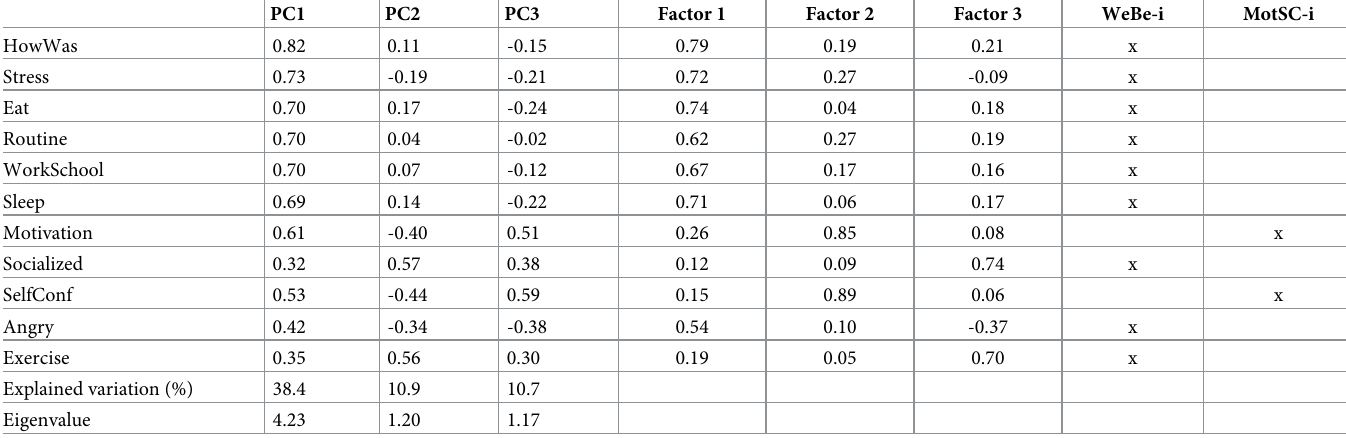
Table 4. Principal components (PC1-3), varimax rotated factor loadings and the belonging to the 2 digital